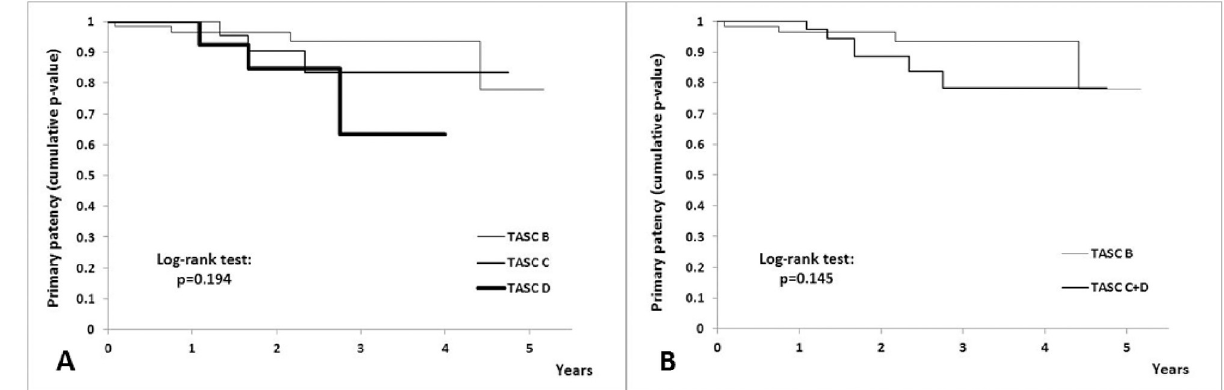
Fig 4. Kaplan-Meier primary patency rates for TASC II classification. (A) TASC B vs . TASC C vs . TASC D. (B) TASC B vs . TASC C/D.